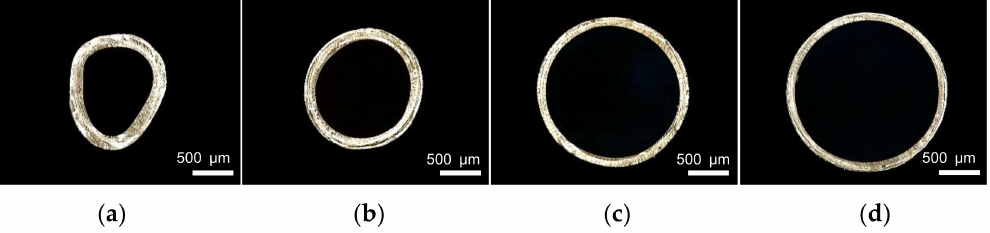
Figure 15. The cross section of micro tubes at different gas flow rates: ( a ) Gas flow rate = 5 g/min; ( b ) Gas flow rate = 20 g/min; ( c ) Gas flow rate = 35 g/min; ( d ) Gas flow rate = 50